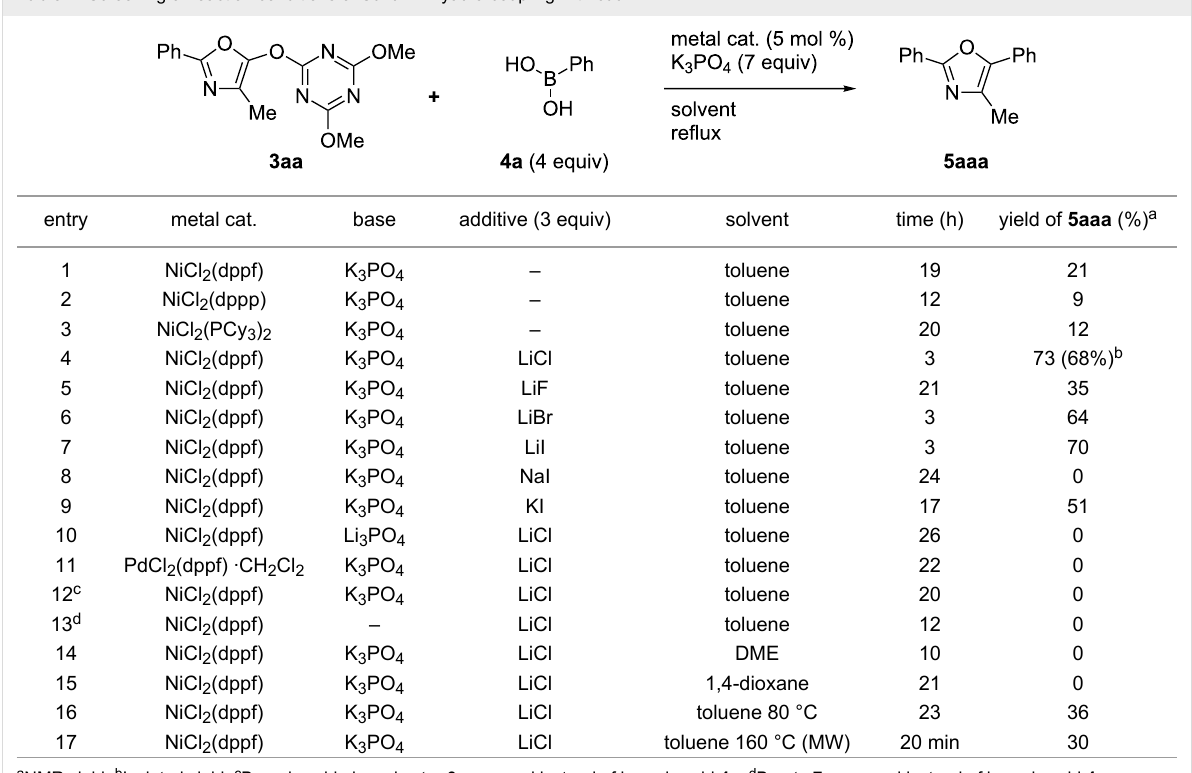
Table 2: Screening of reaction conditions of Suzuki–Miyaura coupling with 3aa